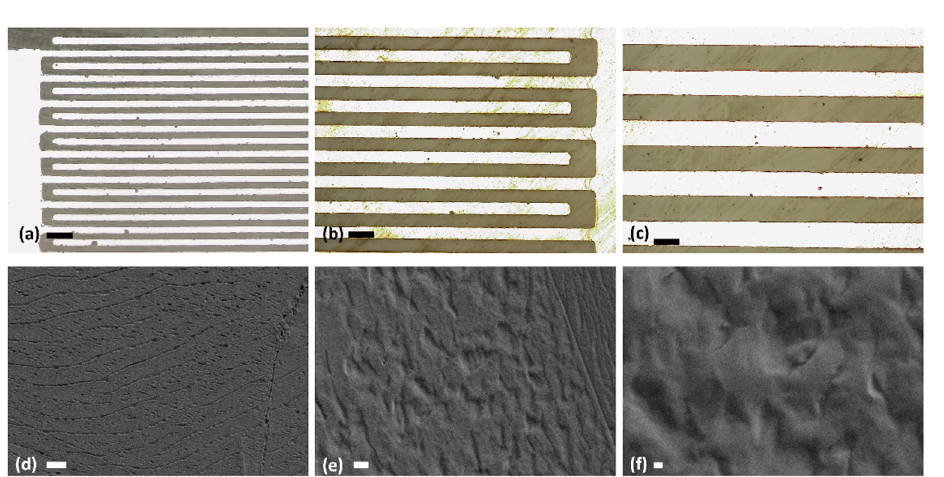
Figure 3. ( a – c ) Microscopic images of the reverse-offset printed IDTs after sintering, showing the dimensions of the IDTs fingers width and gaps, [scale bar- a: 200 µm, b: 100 µm, c: 50 µm] ( d – f ) SEM images of the sucrose film at different magnifications. Scale bars (d: 10 µm, e: 1 µm, f: 200 nm).